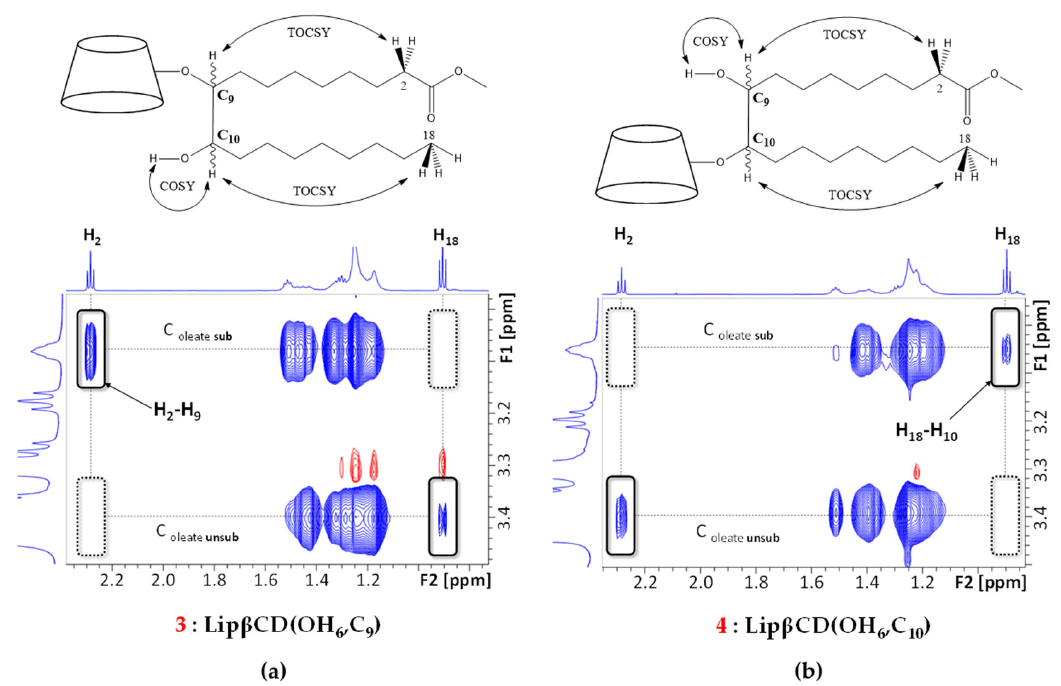
Figure 7. Partial contour plots of 2D TOCSY experiments (600 MHz, DMSO/D 2 O 98/2, v / v ,298 K, t m = 160 ms) of compounds 3 ( a ) and 4 ( b ). The strategy to determine the grafted position of the methyl oleate carbon is shown at the top of the contour plots.